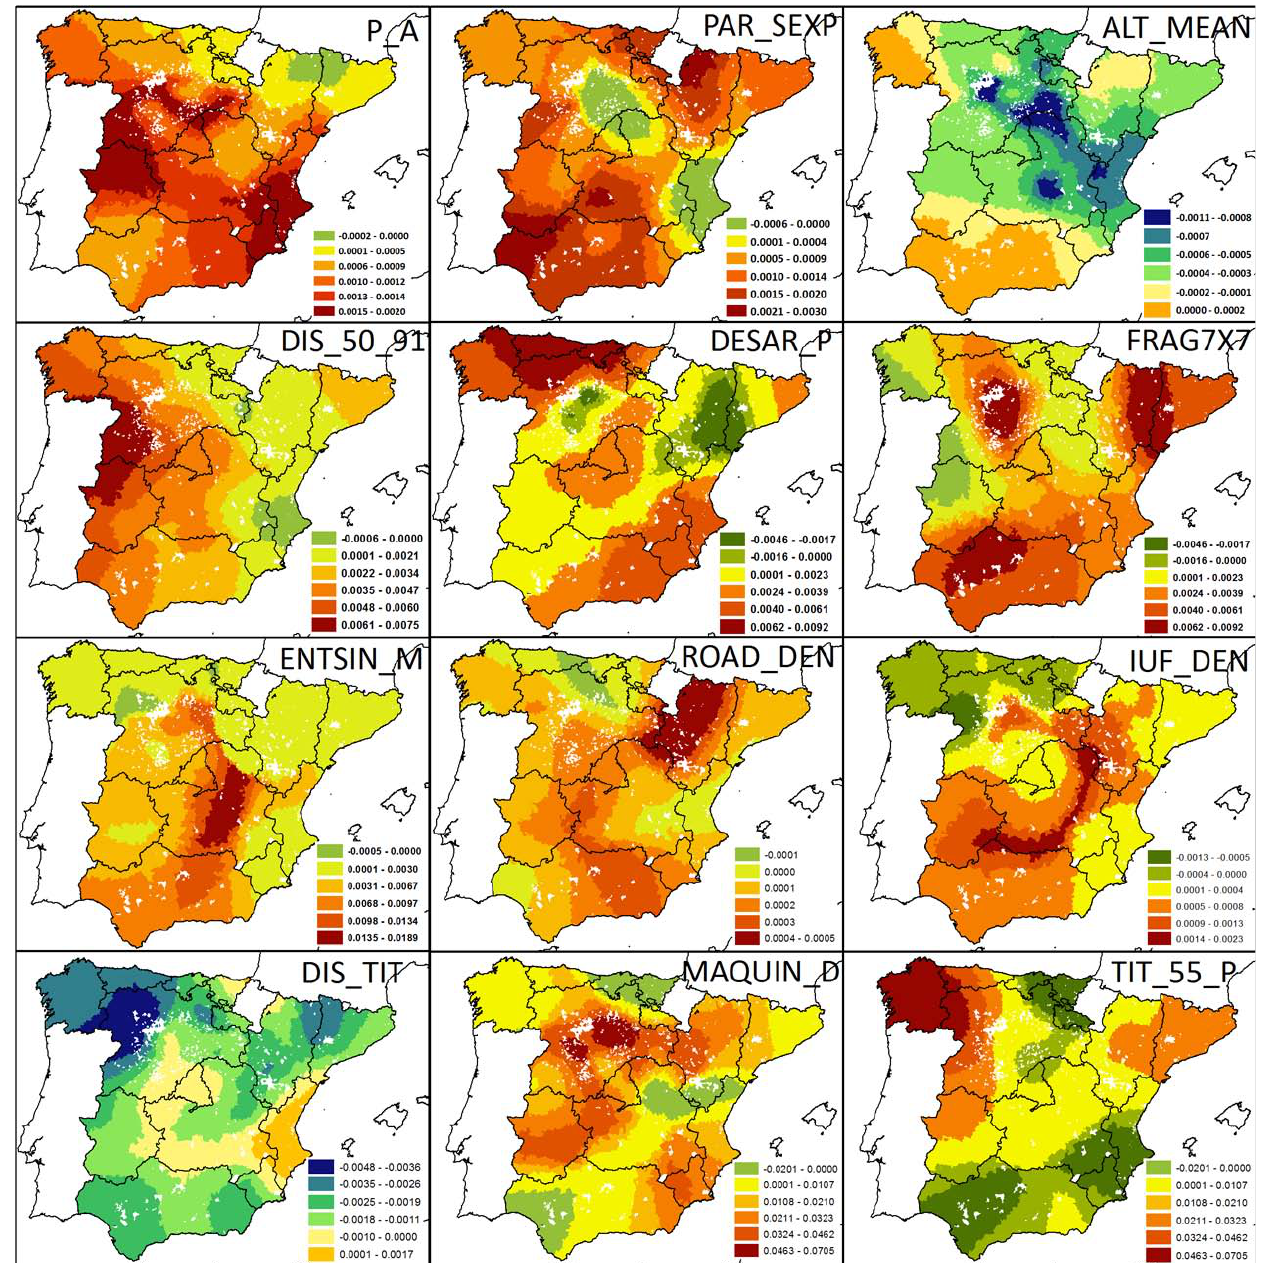
Fig. 7. Local coefficients for adaptive GWR linear model using a bandwidth of 1300 nearest neighbours. Negative coefficients are mapped with cold colours (green to blue) and positive with warm colours (orange to red). Variable names and their descriptions are in Table